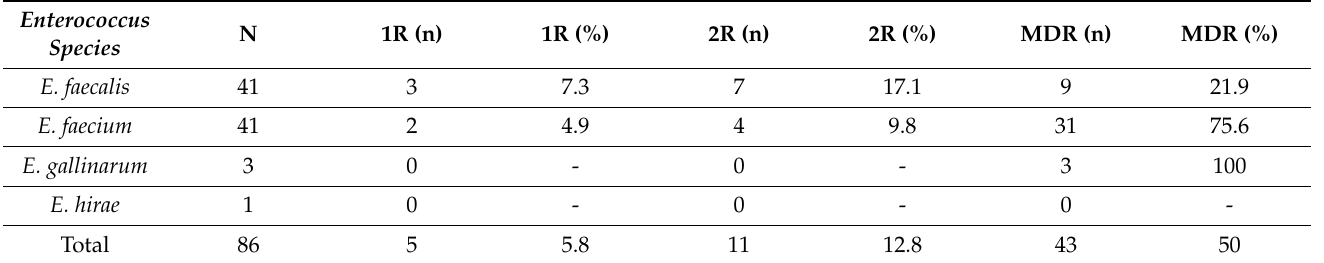
Table 1. Antibiotic resistance profile of Enterococcus spp .